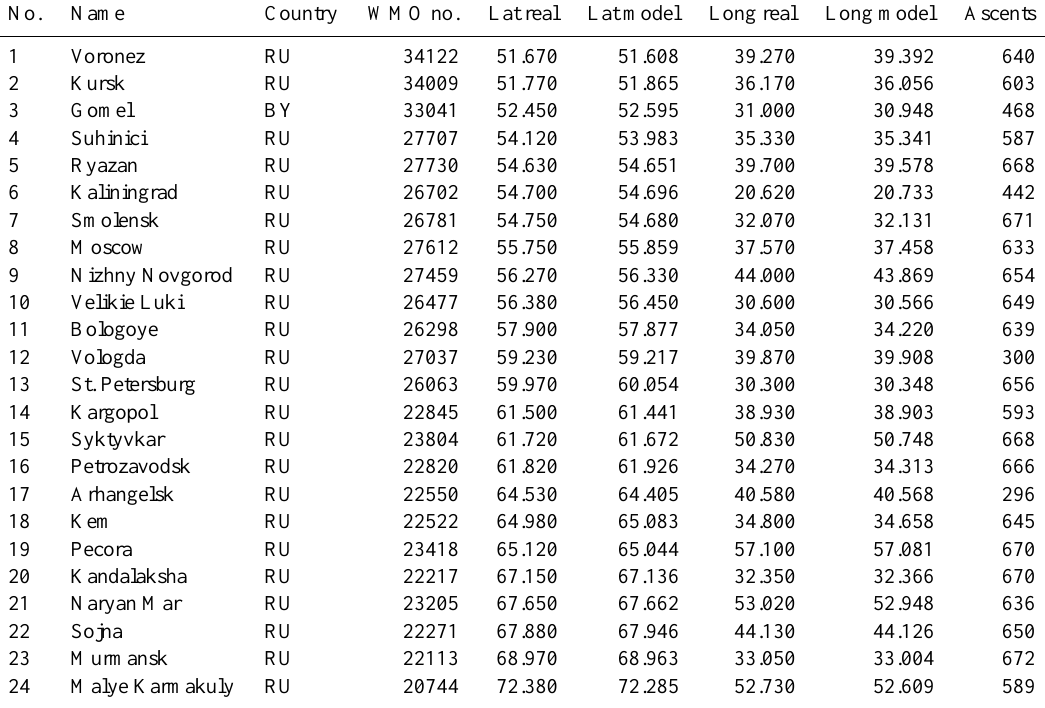
Table B2. Specifications of the Russian stations from which data were used in this study, listed from south to north. Real coordinates are those of the true location, model coordinates those of the closest grid point used to compare measurements and model data. No.